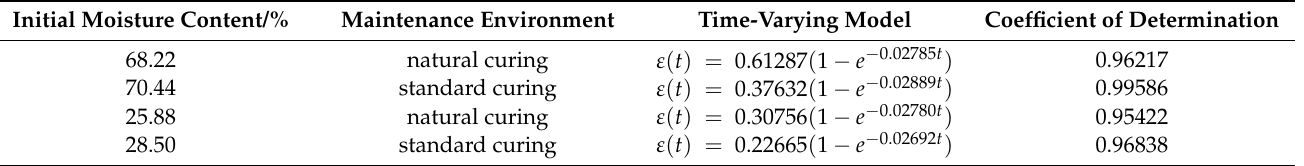
Table 10. Time-varying model of drying shrinkage